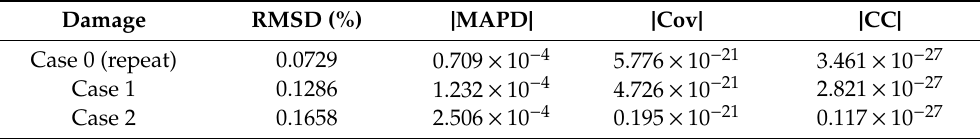
Table 5. The value of EMI indicators at di ff erent damage